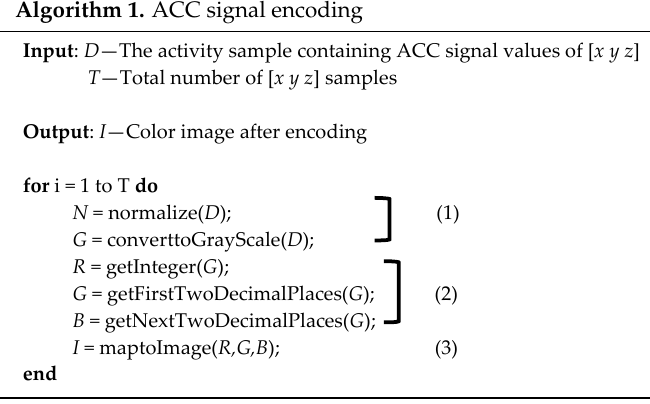
Algorithm 1. ACC signal encoding